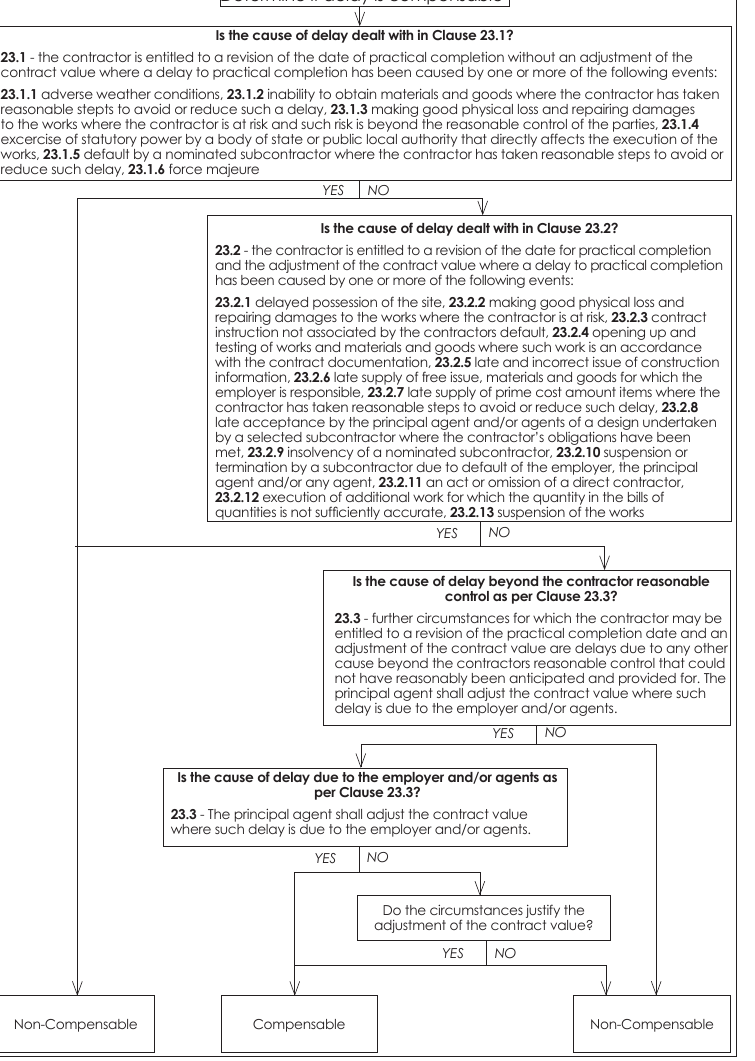
Figure 15: Decision tree JBCC: to determine if delay is